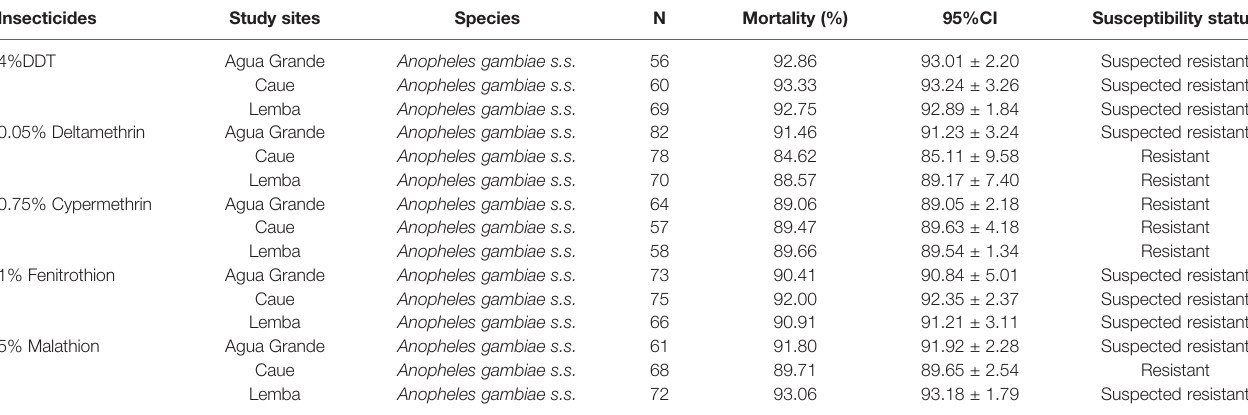
TABLE 4 | Susceptibility status of Anopheles gambiae s.s. collected in the study sites and exposed to the fi ve classes of insecticides. Insecticides